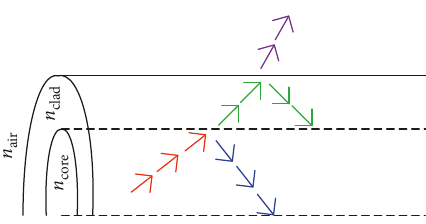
Figure 5: Schematic view of small-time-step-based ray-tracing [1] (vector size was exaggerated for